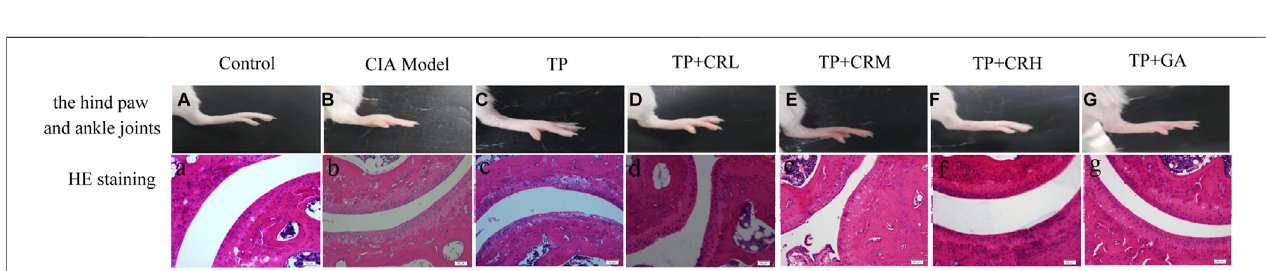
FIGURE 6 | Photos of right hind paws (A – G) and histopathological analysis of ankle joints stained with H&E (a – g) .